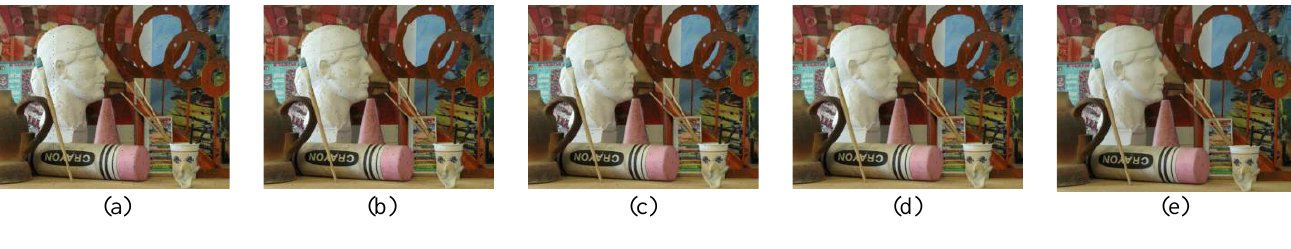
Figure 7. Virtual view synthesis by the proposed method for "Art" considering different thresholds (a) T=10 (b) T=5 (c)